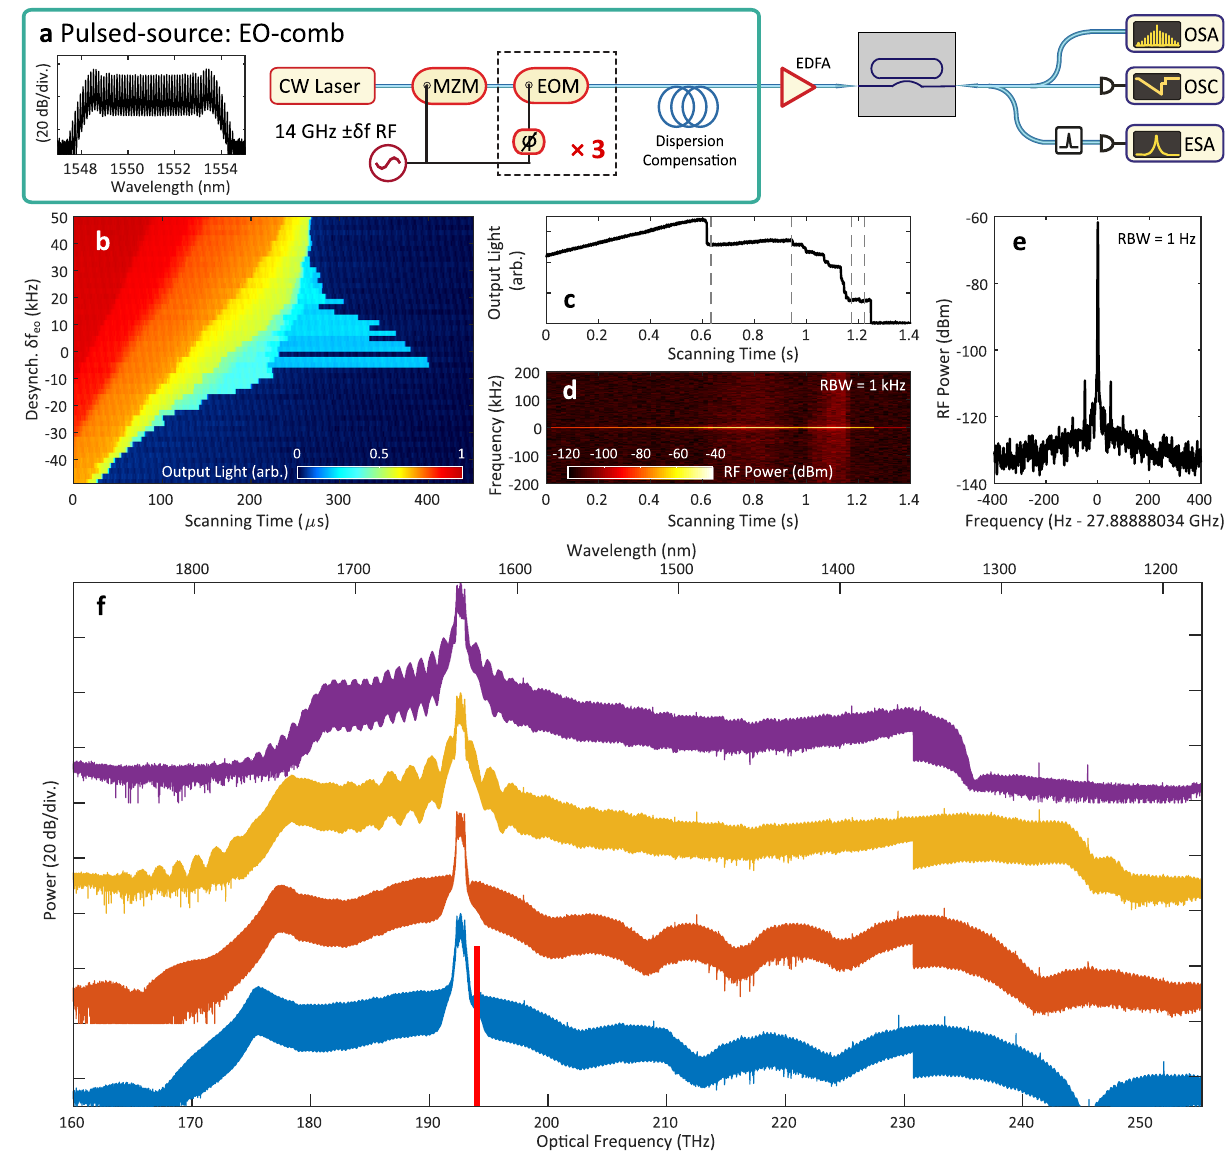
Fig. 4 | Experimental pulse-driven switching wave and zero-dispersion soliton formation, MR1. a Setup, featuring the EO-comb as a pulsed-source. MZM: Mach-Zehnder modulator, EOM: electro-optic modulator, EDFA: erbium- doped fi ber ampli fi er, ESA: electronic spectrum analyzer, OSA: optical spec- trum analyzer, OSC: oscilloscope. The input pulse train is coupled into and out ofthemicroresonatorchipvialensed fi bers.Left-inset:Spectrumofthe14GHz EO-comb before ampli fi cation. b Spectrogram of the step feature for different